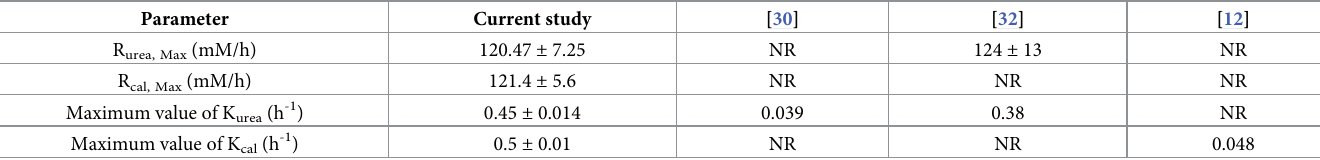
Table 6. Comparison of kinetic constants reported in the previous literature with the current